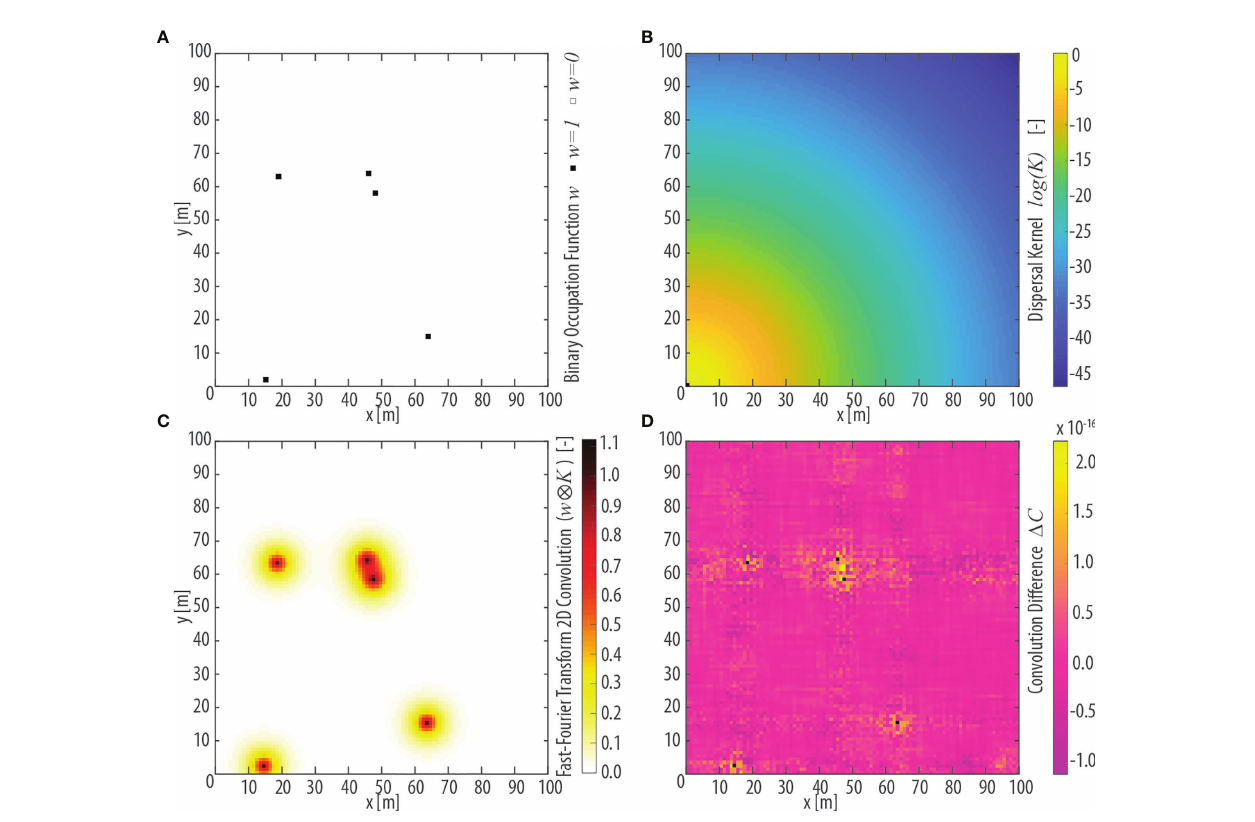
FIGURE 3 | Conceptualization of vegetation dispersal illustrated in a square, 100m-wide, idealized lattice domain. (A) The n =5 pixels colonized by a given focus species i are represented by a binary occupation function w i,n . (B) Value of the dispersal kernel k as a function of the euclidean distance d of each pixel from the pixel in the lower-left corner within the idealized lattice. The characteristic dispersal length for k is assumed equal to D =3 m. (C) Results of the 2D convolution w i,n ⊗ k (d) between the occupancy fi eld w i,n and the dispersal kernel k (d) shown in panel (A, B) , respectively, computed using the Fast-Fourier Transform (FFT) algorithm. (D) Absolute difference D C in the value of the 2D convolution w i,n ⊗ k (d) computed explicitly and using the FFT algorithm. Black dots denote pixels occupied by the focus species [see panel (A) ] in which D C =0